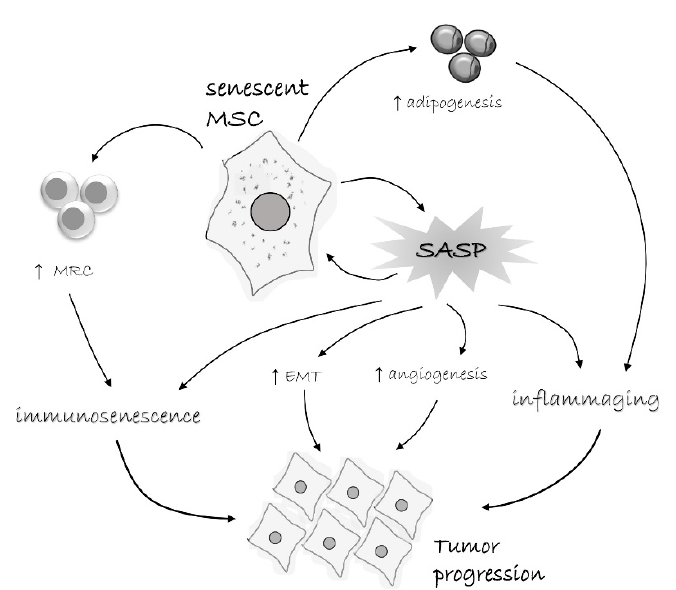
Figure 2. Tumor-promoting characteristics of senescent MSCs. Senescent MSCs acquire senescence-associated secretory phenotype (SASP) and secrete a range of pro-inflammatory cytokines, chemokines, growth factors, pro-angiogenic, anti-apoptotic, and other bioactive molecules. Senescent MSCs also have biased differentiation capacity toward adipocytes, which by themselves produce diverse pro-inflammatory factors. All this lead to a low-grade para-inflammatory state. On the other hand, these factors induce immunosenescence, but also lead to the induction of myeloid regulatory cells (MRC), like MDSC, M2 macrophages, and tolerogenic DC. This creates a tumor-permissive environment and together with other pro-tumorigenic effects, like stimulation of adipogenesis and epithelial-to-mesenchymal transition (EMT), supports tumor progression.